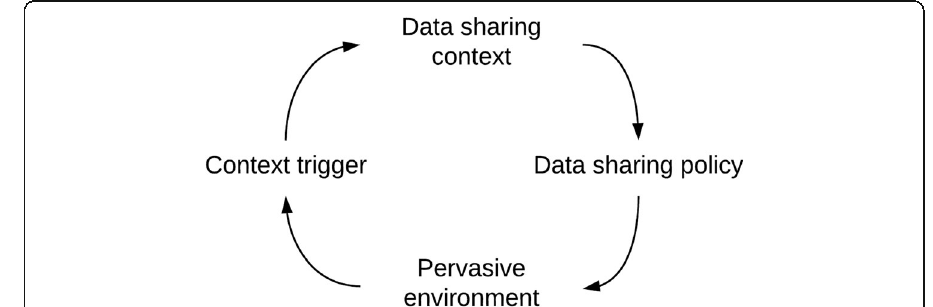
Fig. 6 Context triggers activate refinement of data sharing